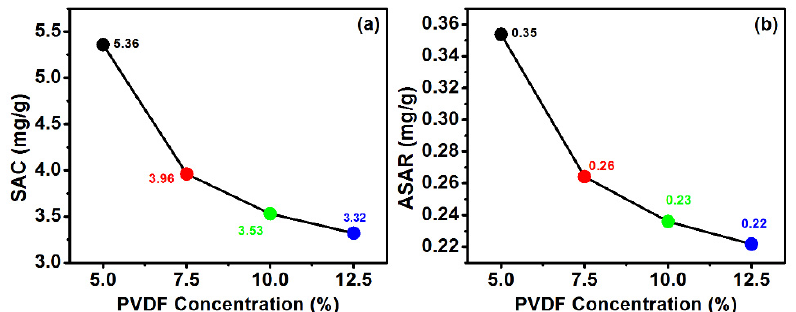
Figure 10. ( a ) Salt absorption and ( b ) average salt absorption capacity of the prepared electrode.